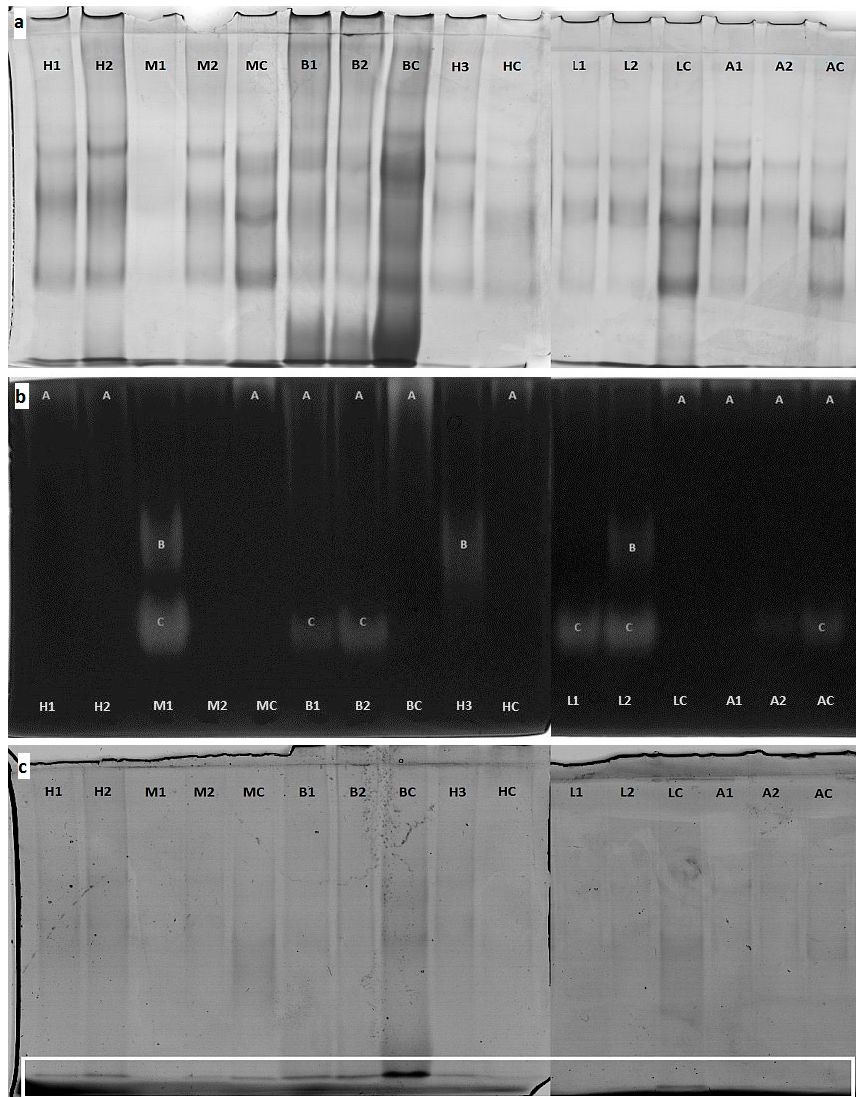
Figure 1. Gels from native PAGE electrophoresis ( a ) for total protein stained with Coomassie Brilliant Blue, ( b ) for amylase activity, and ( c ) for acid phosphatase activity. A,B,C—amylase fraction, the white box marks the location of the acid phosphatase band.